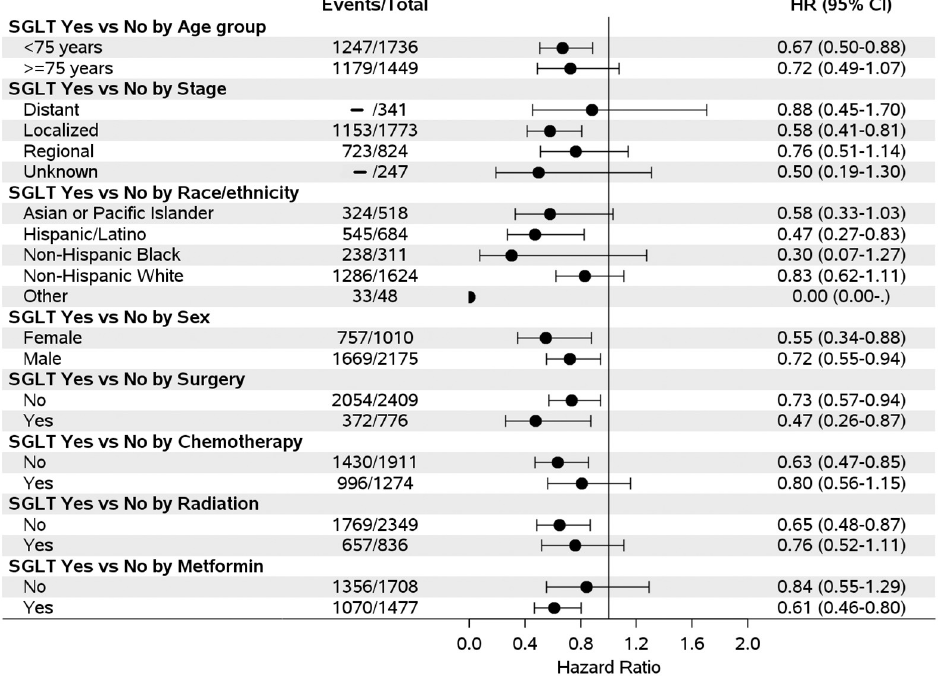
Fig 2. Forest plot of association between sodium-glucose cotransporter 2 (SGLT2) inhibitor use and hepatocellular carcinoma mortality by covariates (- Numbers have been suppressed to protect confidentiality).